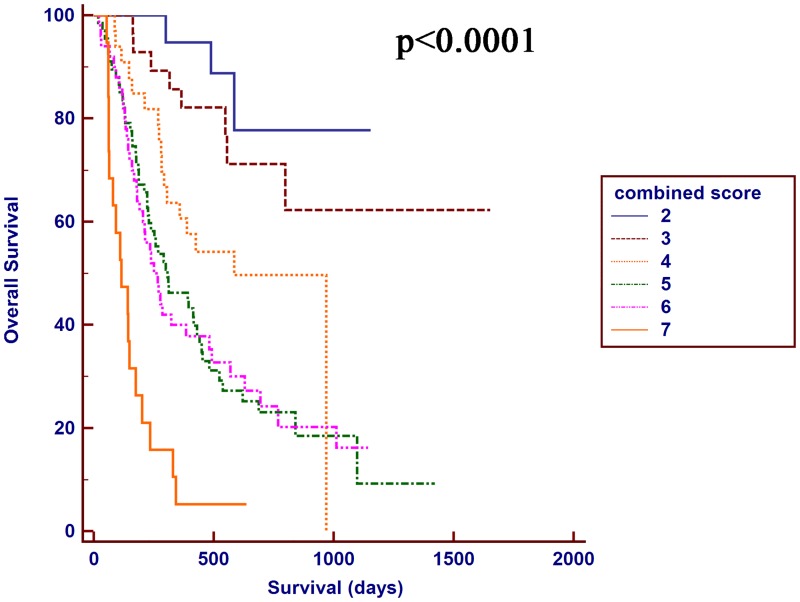
Kaplan-Meier OS curves for the patients with HCC who were treated with TACE combined with H101 stratified by the combined score.